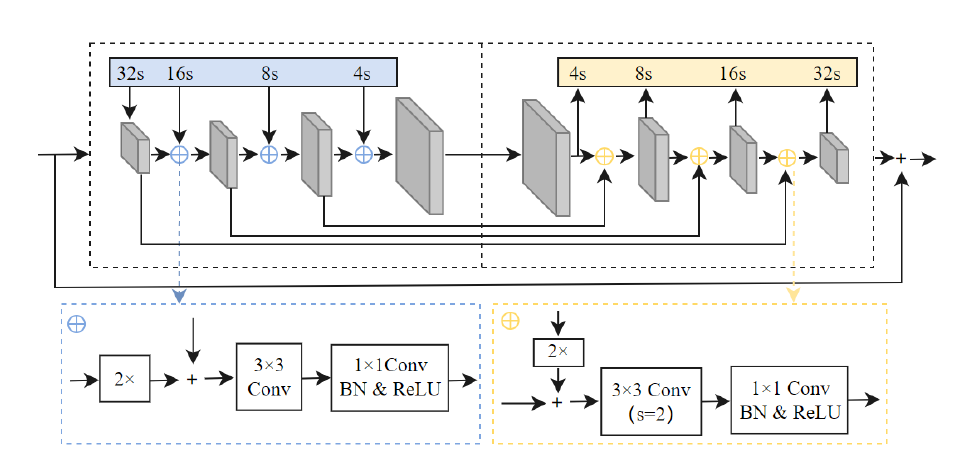
Figure 2. The feature refinement module named as